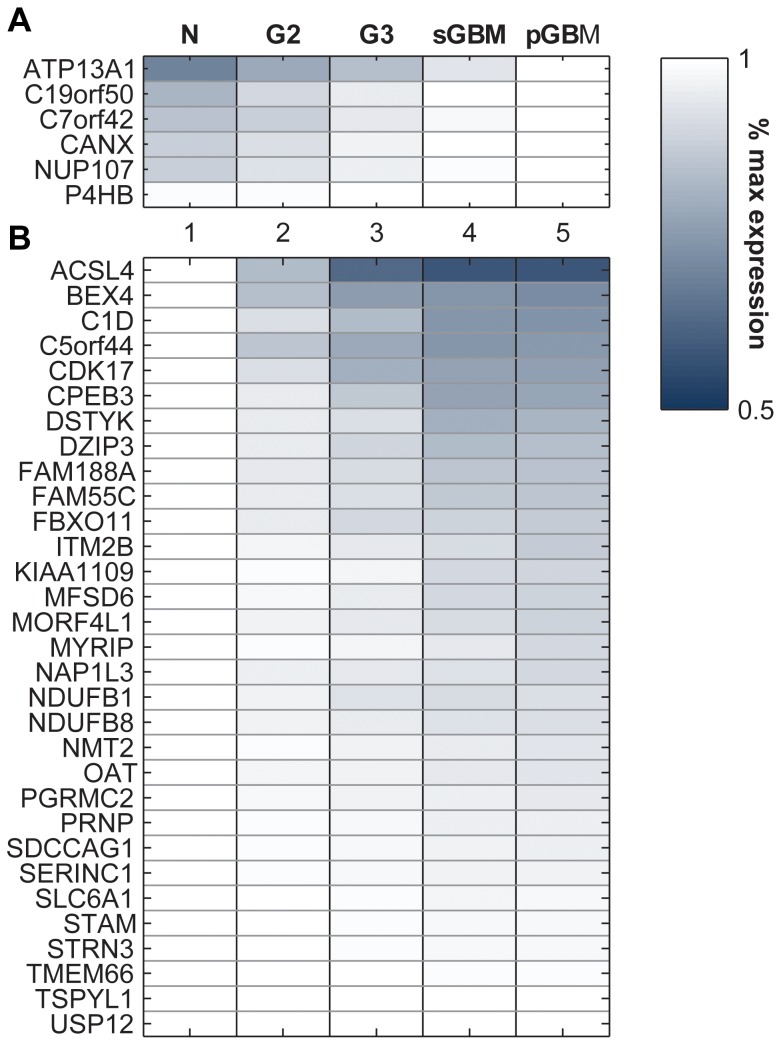
Genes showing consistent differential expression with progression.Colors on the heatmap represent relative expression values of genes in different phenotypes. The vertical axis lists the differentially expressed genes and the horizontal axis lists the phenotypes. All expression values are normalized as the percentage of maximum expression value for the gene across all phenotypes. For the up-regulated genes in panel A) the maximum expression is either sGBM or pGBM, so we see all genes have brightest color in these two phenotypes; similarly the down-regulated genes in panel B) decrease their expression systematically from normal to GBM, and the intensity level also increases with grade.